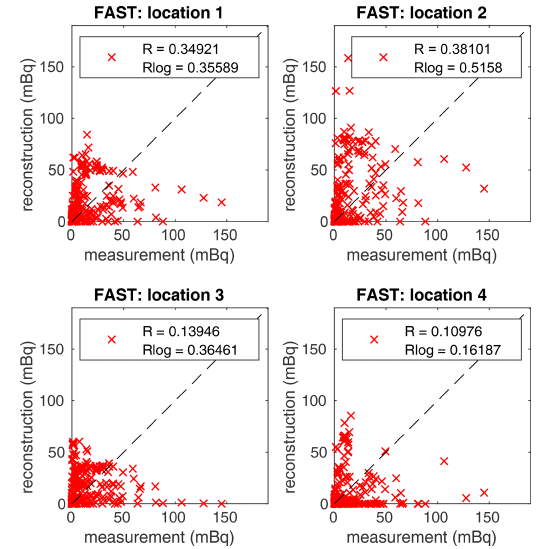
Figure 8. Scatterplots between the IAEA measurements and recon- structions using the RAW, WEEKS, FAST, and CUT datasets (spec- ified in titles) for location 2, Mayak. Computed correlation coeffi- cients and correlation coefficients of the logarithm of concentrations are given in the legends.